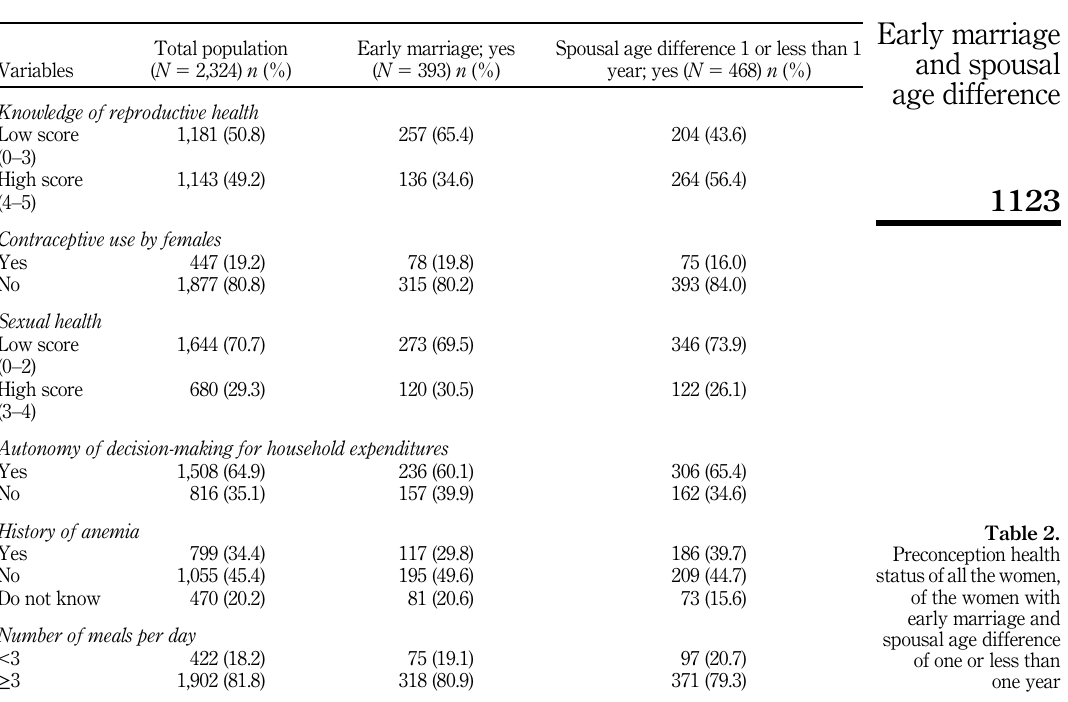
Table 2. Preconception